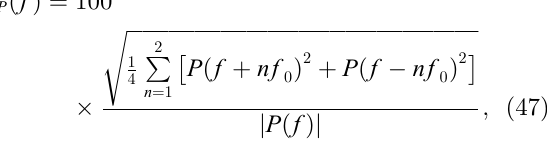
t Þ . Intermodulation c ð